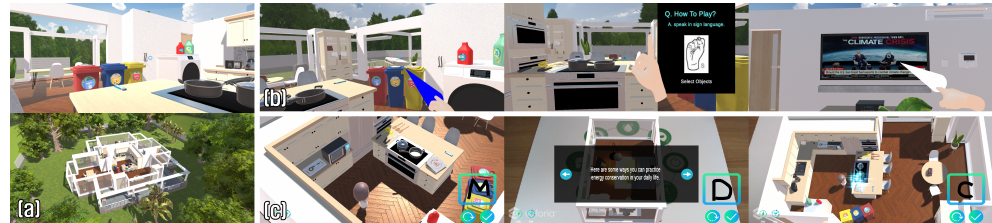
Figure 8. Results obtained from creating educational content by applying the DAVE experience environment: ( a ) content scene, ( b ) VR user, ( c ) AR